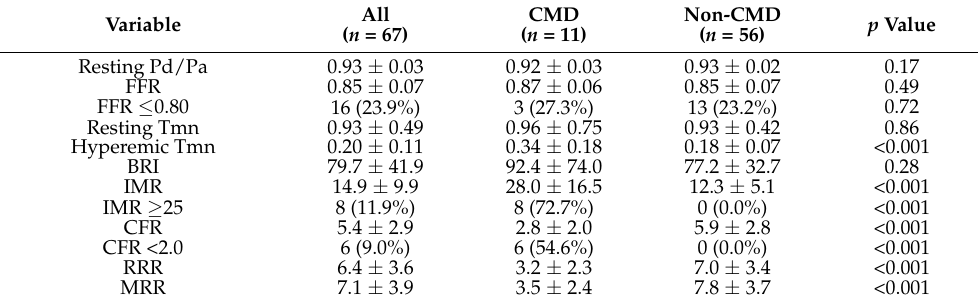
Table 4. Physiological findings under intracoronary papaverine-induced hyperemia.